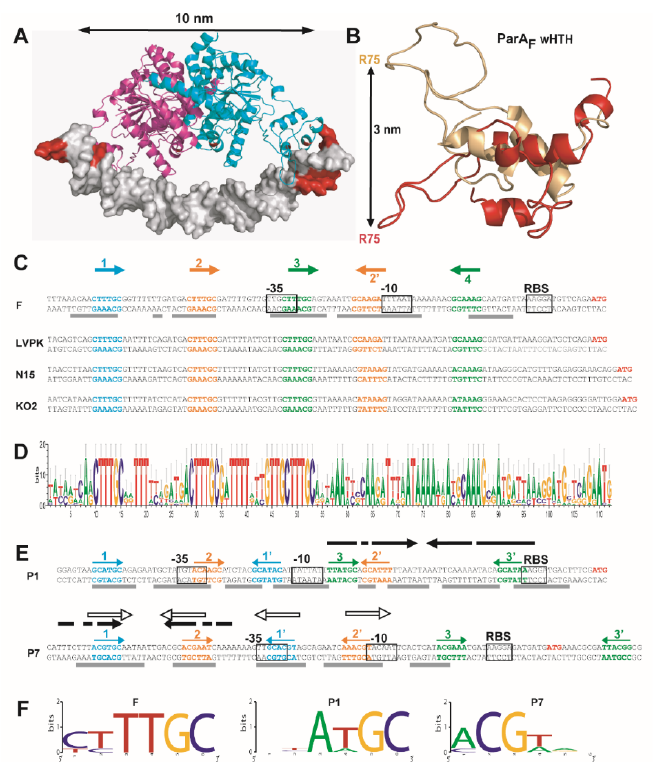
Figure 5. Type Ia plasmid ParA binds to overlapping motifs arranged as inverted repeats. ( A ) Docking ParA F onto P parAB F . ParA F from the modeled structure was docked onto a 40-bp DNA carrying the IR 3-4 motif. Different DNA bending angles (see Material and Methods) were assayed with one possible conformation of ParA F dimer. The best docking on the binding motifs was observed with a 120° DNA curvature. ParA F monomers are represented in magenta and cyan. The DNA is displayed in gray with the binding motifs #3 and #4 colored in red. ( B ) The winged-HTH domain of ParA F undergoes large conformational rearrangement. The backbone of the wHTH is superimposed before (red) and after (salmon) 40 ns MD simulation. The distance between the C- α atoms of arginine 75 (R75) in the initial and final states is shown by a black line. The full structures are presented in Figure S6B. ( C ) Par promoter regions of the plasmid F and close homologs display a strong conservation of the ParA binding motifs. The sequences of P parAB F and of three close homologs from LVKP (large virulence plasmid pLVPK of Klebsiella pneumoniae CG43), N15 (linear prophage N15 of E. coli ) and KO2 (phage phiKO2 of Klebsiella oxytoca ) are shown up to the parA start codon (ATG) colored in red. The -10 and -35 transcriptional signals and the ribosome binding sites (RBS) are indicated by open boxes. Binding motifs #1 and IR 2-2 ′ and 3-4, are written in blue, orange and green, respectively, and are represented with corresponding colored arrows. The grey lines below the P parAB F sequence corresponds to the regions protected by ParA F in footprint experiments [21]. ( D ) Partition promoters related to P parAB F display a high level of conservation for the inverted repeats motifs and their spacing. Sixteen different partition promoters recovered from BLASTn searches using the Par promoter regions of F, LVPK, N15 and KO2 were subjected to quantitative Logo analysis [35]. The sequences and the alignment of these promoter regions are presented in Figure S5. ( E ) Promoter regions of the par operons of plasmids P1 and P7. DNA sequences and promoter core signals are displayed with the same color codes and drawings as in C. Inverted black and open arrows indicate the imperfect repeat sequences and the DNA binding motifs, respectively, identified previously [10]. The regions protected from DNAse I footprinting by ParA P1 [32,36] and ParA P7 [10] are indicated by grey lines below each sequence. ( F ) Logo analysis of the proposed ParA binding sites for the plasmids F, P1 and P7. The six proposed binding motifs in the P parAB regions were subjected to Logo analysis, except for the plasmid F for which only five motifs were identified (see main